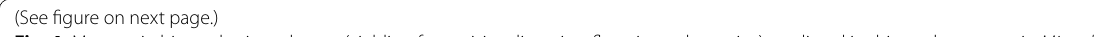
rectangles(See figure on next Fig. 4 Mycotoxin biosynthetic pathways (yielding fumonisin, gliotoxin, aflatoxins, ochratoxins) predicted in this study to occur in Microdochium nivale . Rectangles contain names of the reference proteins involved in the synthesis of corresponding mycotoxins, including those for which orthologs were revealed (green) or were not revealed (grey) in the M. nivale proteome. The IDs of genes for the revealed orthologs are given near the corresponding